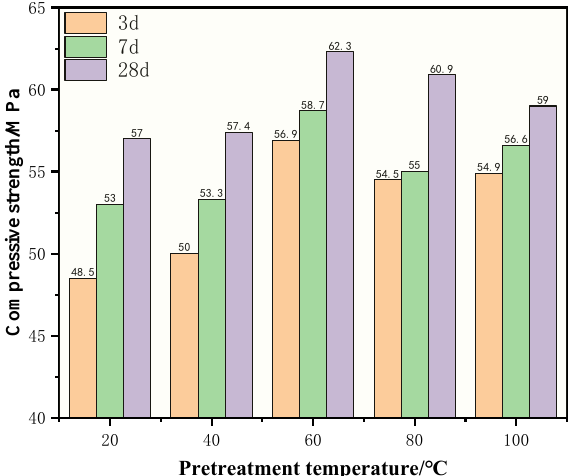
Figure 3. Effect of pretreatment temperature of CDWC on compressive strength development of CDWGC.